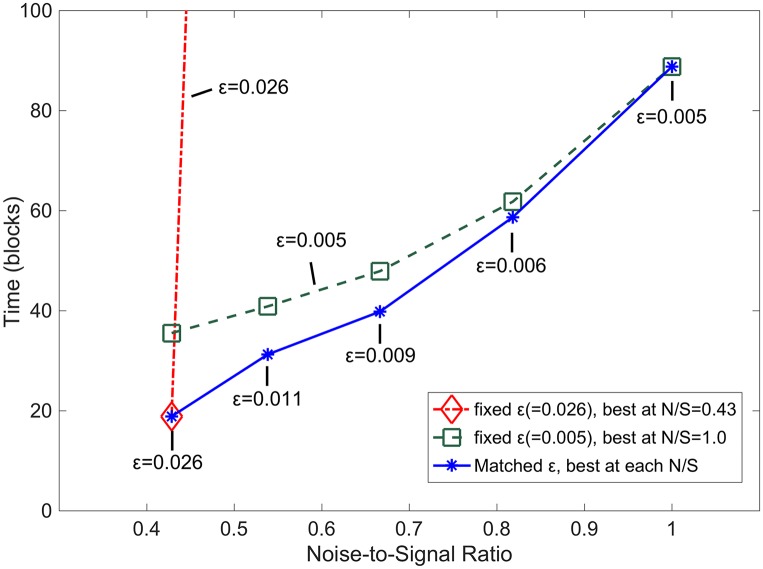
Time penalty for suboptimal parameter selection.The time penalty for suboptimal parameter selection is the difference between the dot-dashed/dashed curves and the continuous curve. This blue curve (*) is the time to stable development at each NSR using the optimal ε for each NSR. The dot-dashed and dashed curves use fixed ε values, with the dot-dashed (red) using an ε value (0.026) optimal for a low NSR (0.43) and the dashed (blue) using an ε value (0.005) optimal for a high NSR (1.0). The values of the points of the dot-dashed, red line outside of the plot are 553, 8,282, 14,790, and 14,988.